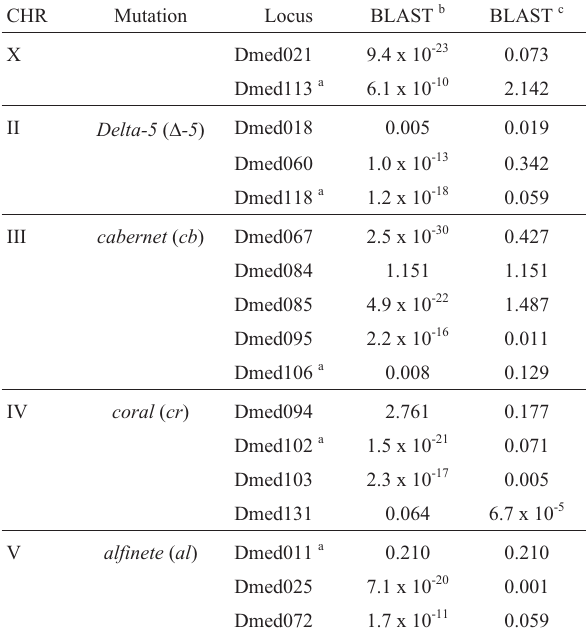
Table 1 - Chromosomal localization of 17 microsatellites loci of D. mediopunctata by synteny with visible phenotype of mutations (auto- somes) or by sex-linked inheritance pattern (sex